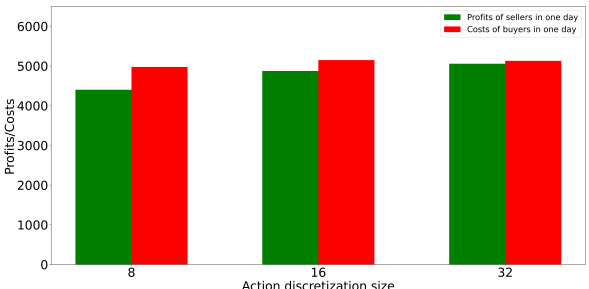
Figure 9. The performance of different action discretization